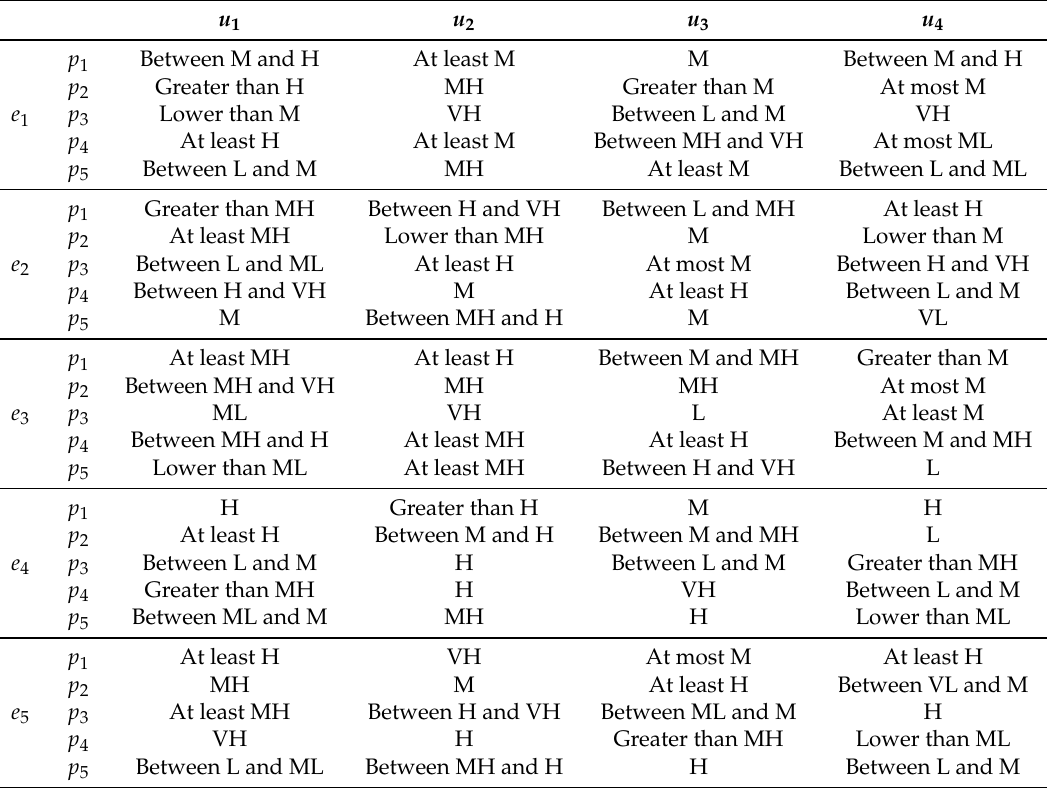
Table 1. Linguistic evaluation of alternatives with respect to each